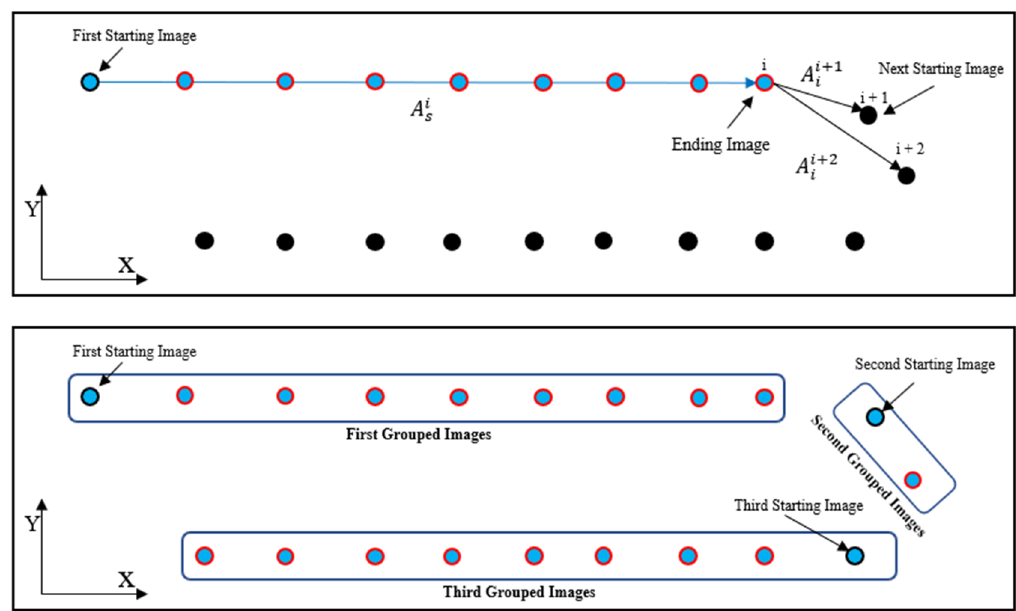
Figure 2. Example of image grouping (top) and its results